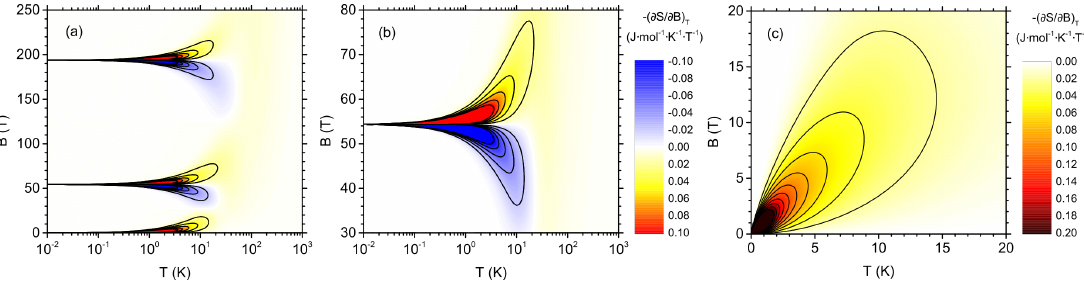
Figure 8. Differential entropy change, − ( ∂ S / ∂ B ) , as a function of the temperature and the magnetic T field. Lines of constant differential entropy change are plotted: ( a ) full range of temperature and magnetic field (in logarithmic temperature scale and linear field scale); ( b ) magnetic fields in the vicinity of the lower critical field (in logarithmic temperature scale and linear field scale); and ( c ) range of weaker magnetic fields (in linear temperature and field scale). The features are visible in the vicinity of the quantum level crossings—for detailed discussion and critical field values, see Appendix